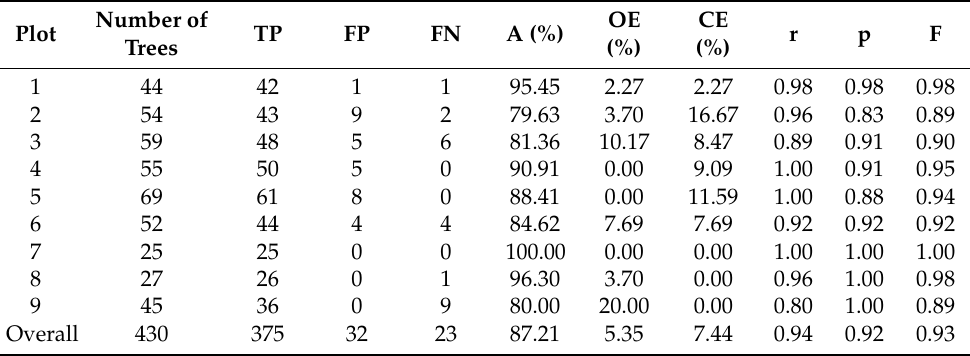
Table 4. Accuracy assessment of tree delineation using pit-free and region growing segmentation model for all sampled plots of Pinus sylvestris plantations. TP = True Positive, FP = False Positive, FN = False Negative, A = Accuracy in percentage, OE = Omission Error, CE = Commission Error, r = recall, p = precision, F = F-score.